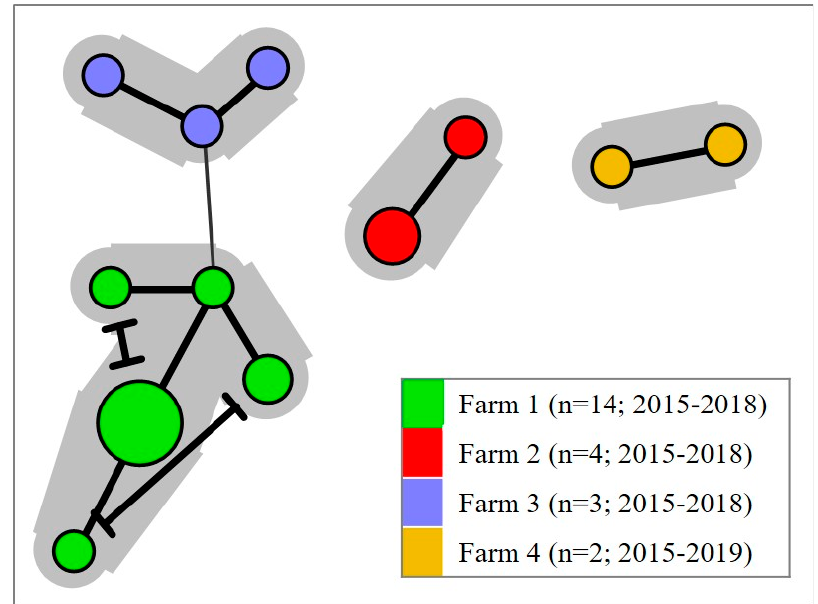
Figure 7. Farm–specific clustering of SGPV variants. Minimum spanning tree (created in BioNu- merics v7.6.3) based on MLVA-profiles from 23 SGPV samples originating over several years (2015– 2019) from four selected freshwater salmon hatcheries in Norway. Thick and thin node connections reflect, respectively, 7/8 and 6/8 shared VNTR loci, while connections of lower similarity are hidden.